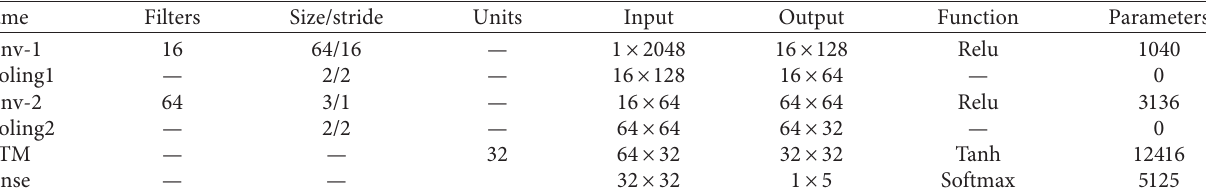
Figure 7: Performance using different kernel numbers at the 2nd convolution layer. Table 3: Parameters of the proposed model.